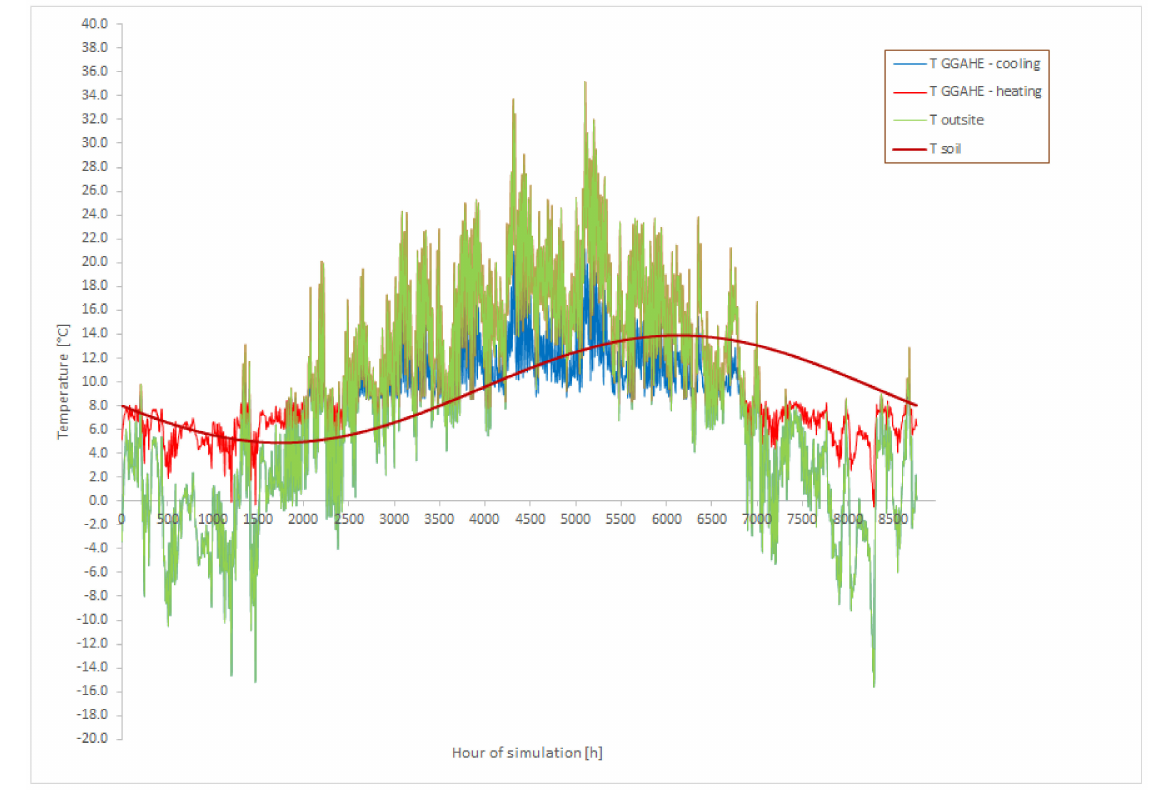
Figure 5. Average ground and outside air temperatures after passing through the